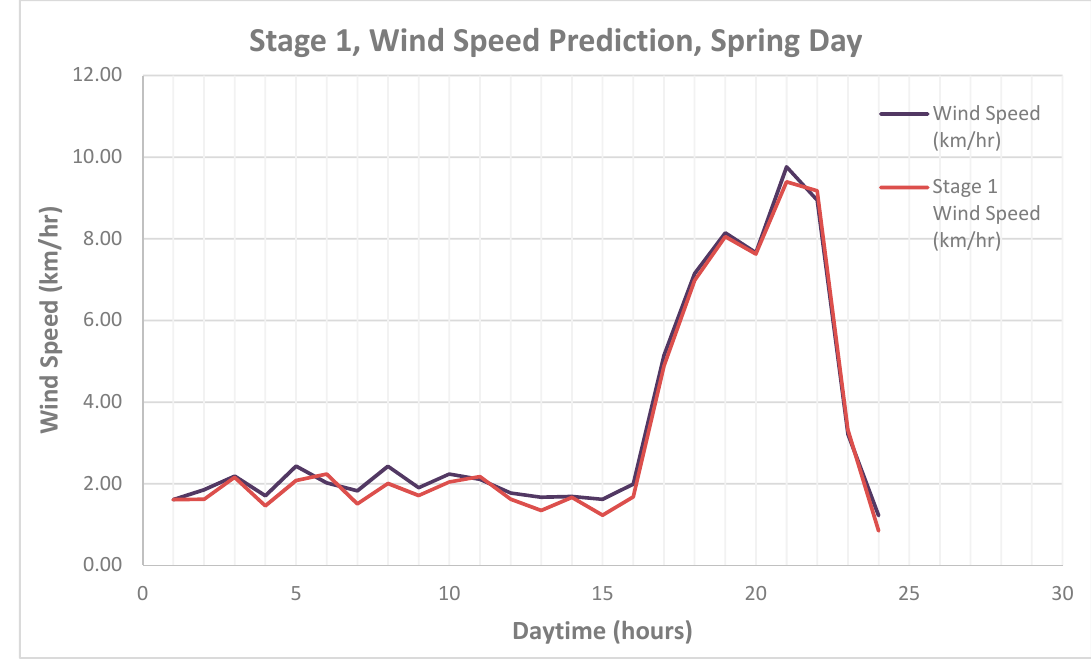
Figure 5. Wind Speed forecasting results from Stage 1, Spring Day.